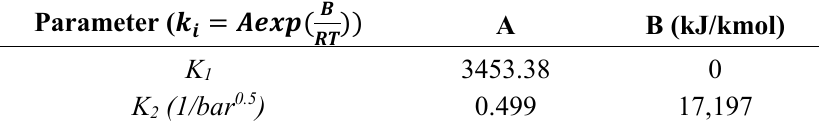
Figure 3. Section 2: Methanol and DME synthesis. Table 2. Kinetic values of the MeOH/DME synthesis reactions